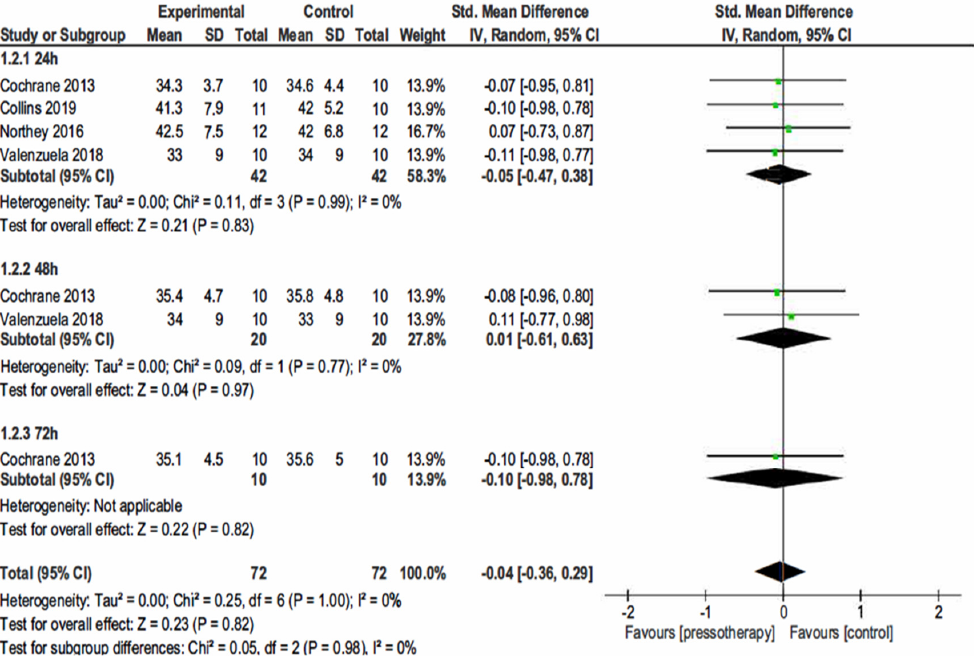
Figure 5. Effects of pressotherapy on jump performance from 24 h to 96 h after exercise. SMDs are calculated from CMJ, VJ, etc.